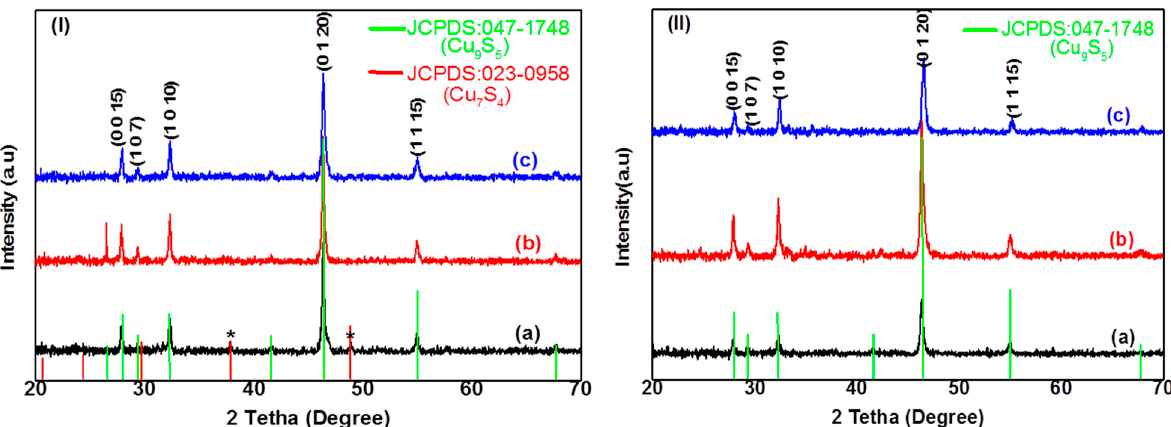
Figure 2. p-XRD patterns of Cu x S y nanoparticles prepared in ( a ) OLA, ( b ) HDA, and ( c ) DDA at 190 °C using ( I ) complex 1 and ( II ) complex 2.